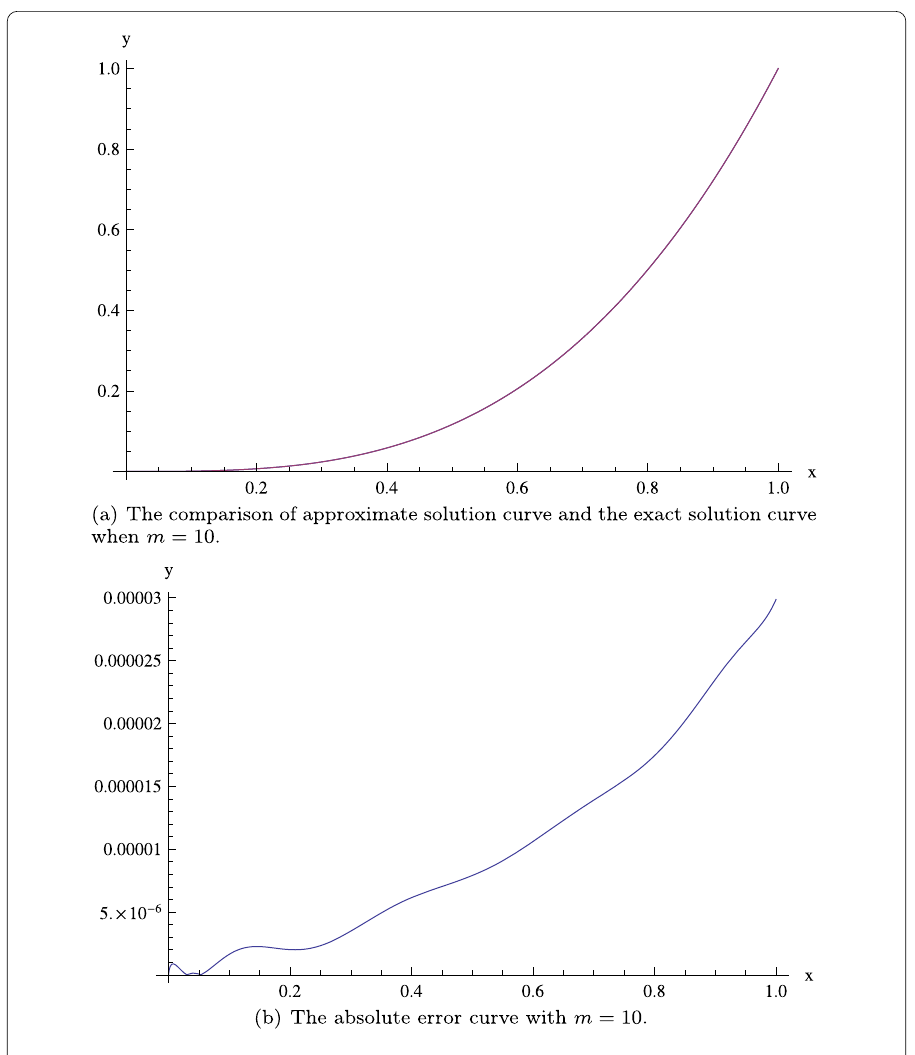
Figure 6 The comparison of the approximate solution and the exact solution when m = 10